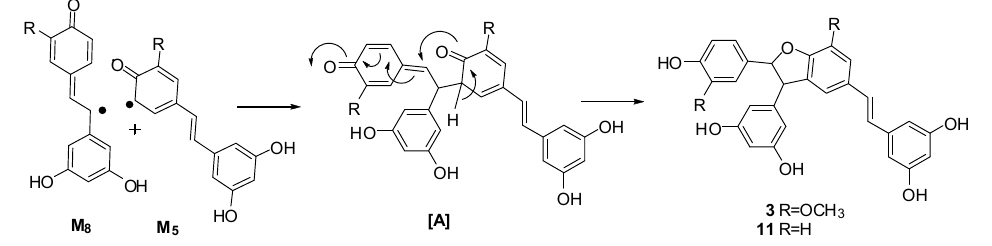
Scheme 2. Proposed coupling mechanism of compounds 3 and 11 .